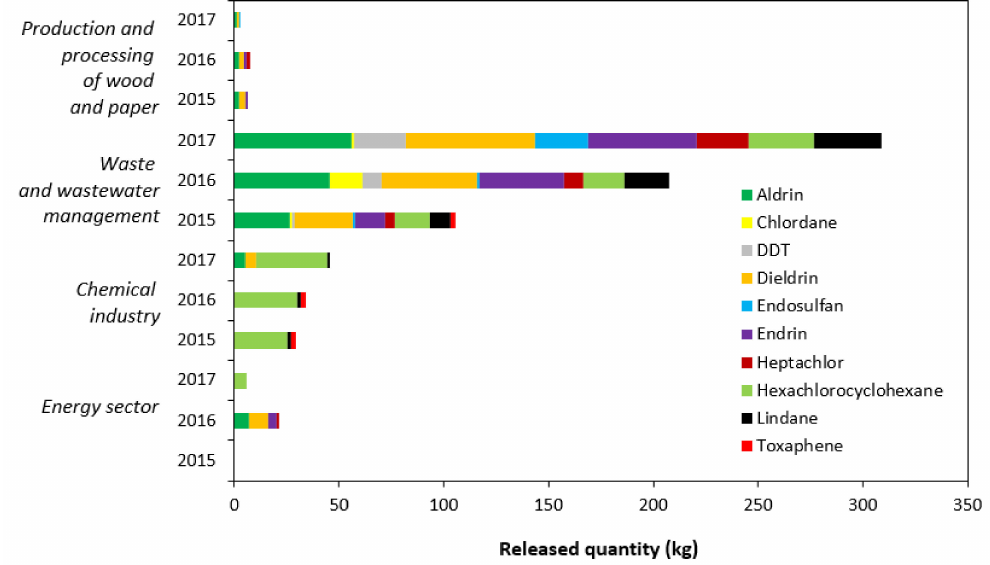
Figure 3. Pesticide emissions from various industrial activities in Europe’s surface waters in the period